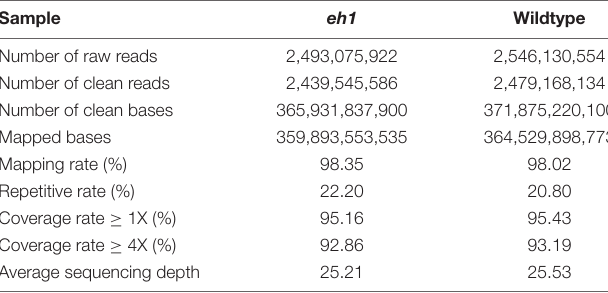
TABLE 1 | Statistics of whole genome re-sequencing and mapping